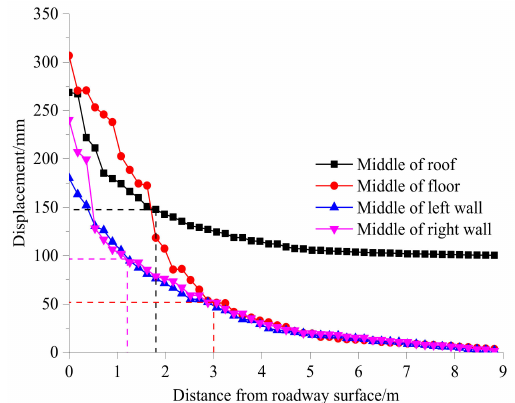
Figure 13. Simulated displacement distribution characters in the di ff erent depth of the roadway surrounding